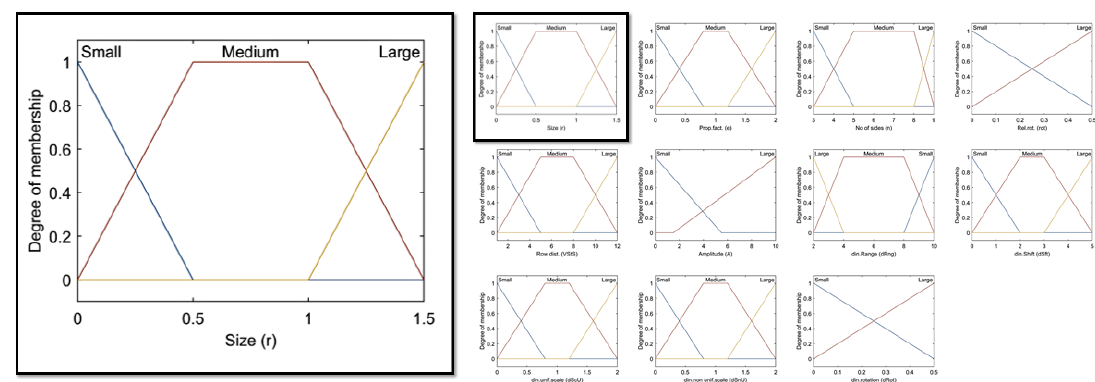
Figure 12. Output membership functions.